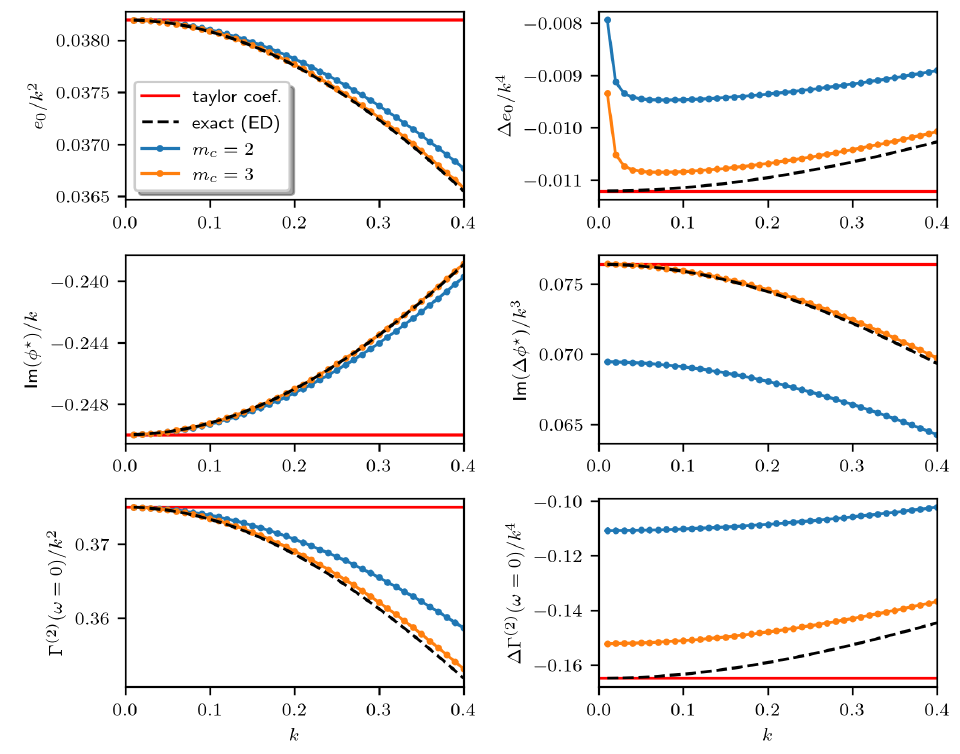
Figure 4: Taylor Coefficients from numerical implementations. We extract them from ED (dashed line) as well as from FRG. We expect the truncation at m reproduce coefficients of order O ( k m c ) . ∆ Q denotes the quantity Q where the lower order Taylor coefficients were subtracted (see main text for a more precise